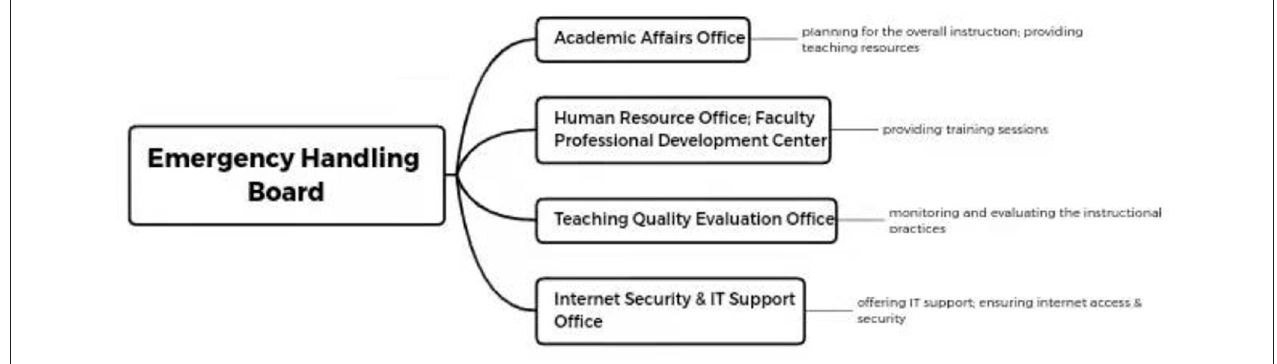
FIGURE 2 | Collaboration from different